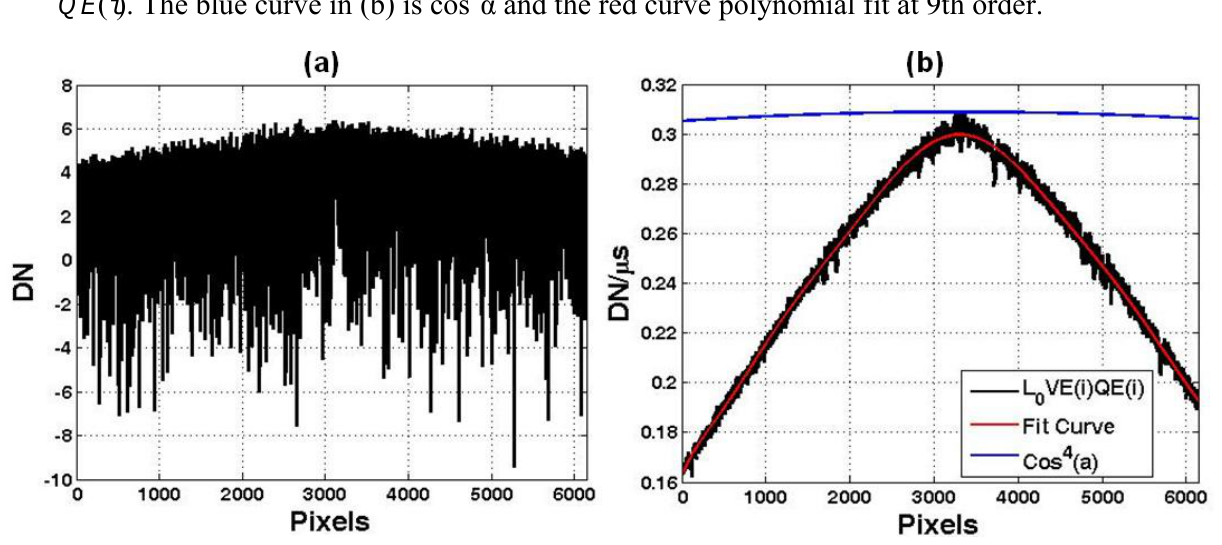
( i ) and (b) L VE ( i ) 0 0